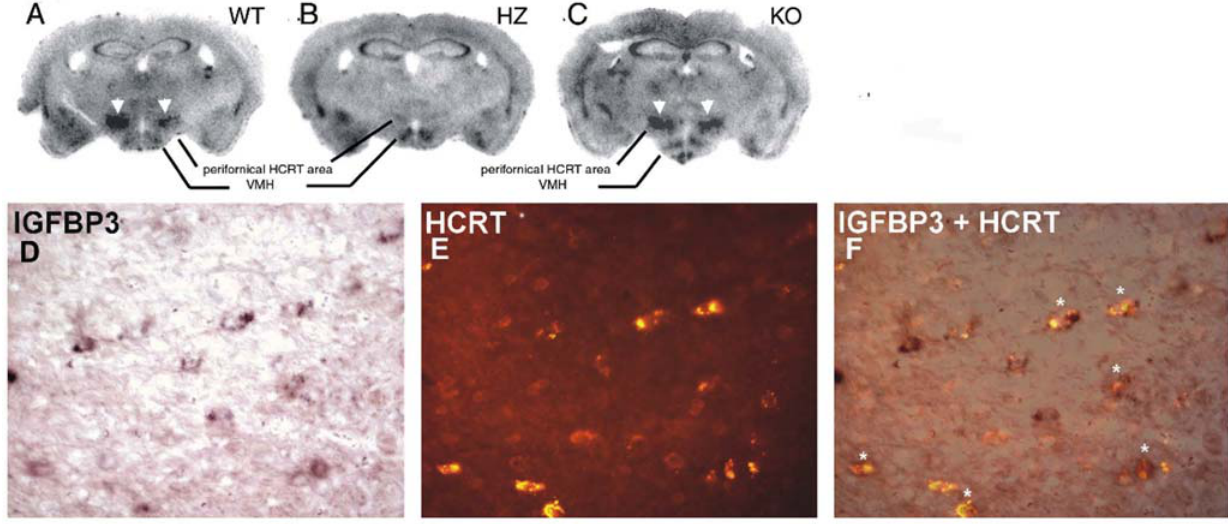
Figure 1. IGFBP3 signals in wild type, ataxin-3 hemizygous, and hypocretin KO mice. The upper panel shows IGFBP3 ISH staining in wild type (A: WT), ataxin-3 hemizygous (B:HZ) and HCRT knockout (C: KO) mice. HCRT staining in neurons (arrowheads) is markedly reduced or absent in the ataxin-3 mouse. The lower panel shows IGFPB3 ISH signal (D: purple; digoxigenin staining with BCIP/NBT), HCRT fluorescence (E: red; Alexa Fluor) immunostaining, and a composite picture (F), indicating that many hypocretin neurons (asterisks) are positive for IGFBP3 in a WT mouse. Scale bar 20 m m.